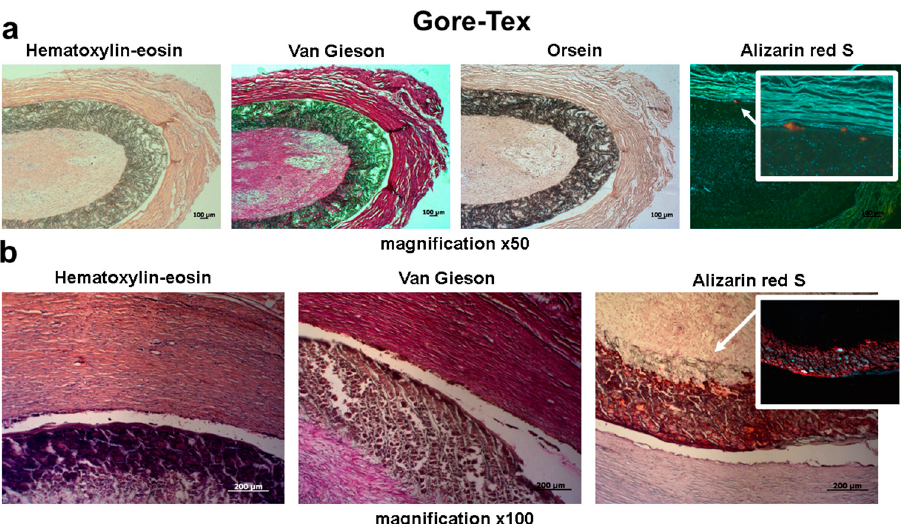
Figure 4. Representative images of GORE-TEX ® grafts explanted 6 months following surgery. Alizarin red S staining showed for both bright field and fluorescence microscopy. ( a ) Representative sample with a single calcium deposit. ( b ) Representative sample with massive deposition of calcium in the graft wall. Scale bar = 100 µ m. Table 1. Primary patency, frequency of thrombosis and wall calcification across study